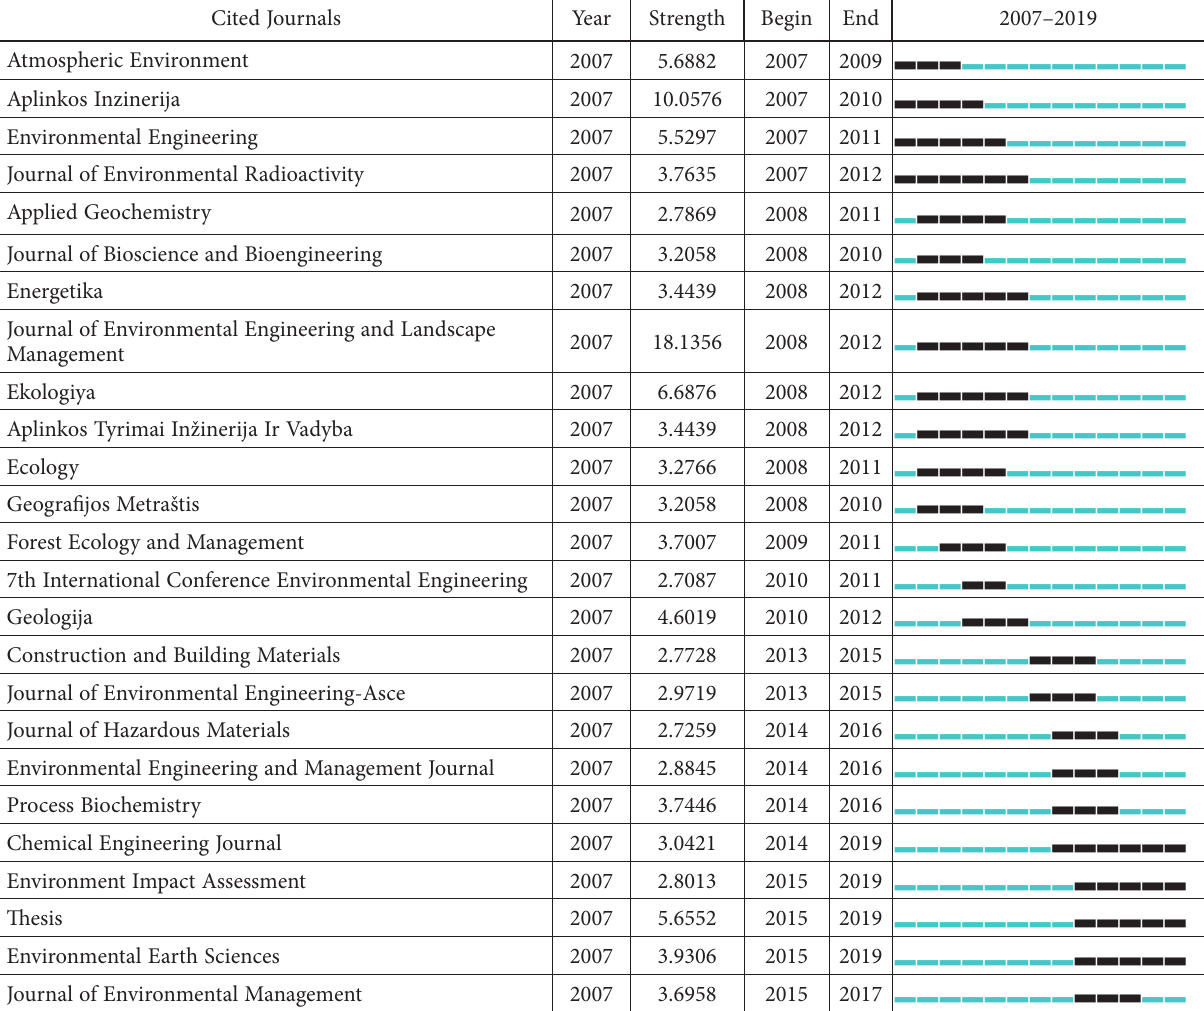
Table 8. Top 25 cited journals with the strongest citation bursts